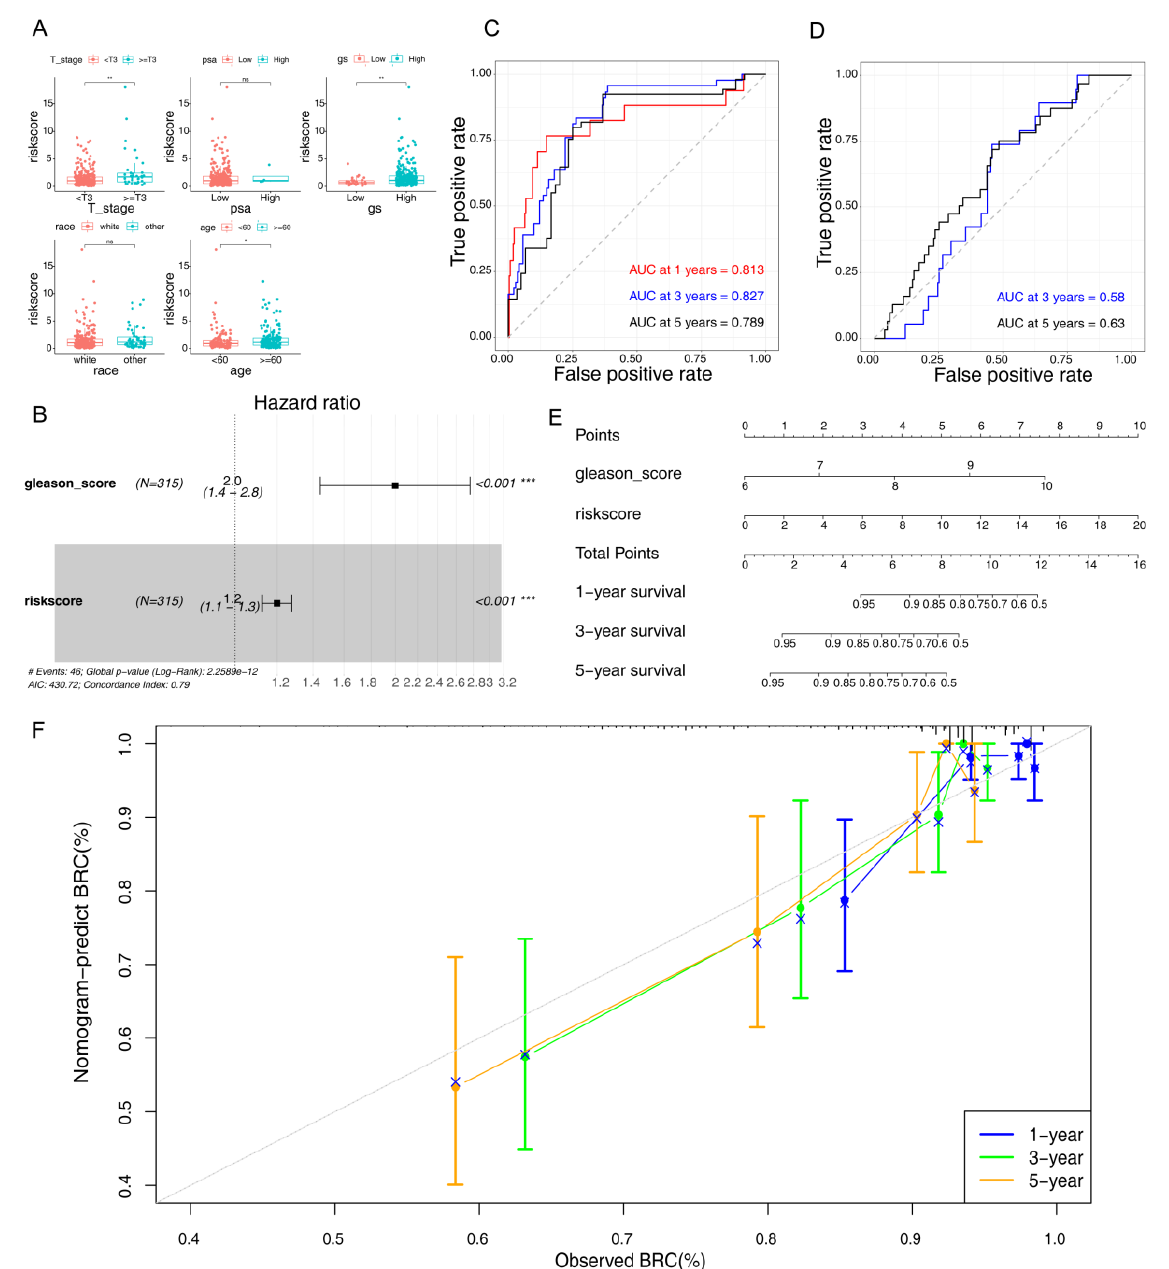
Figure 3. Correlation analysis between the risk model and clinicopathologic features. ( A ) Correlation between risk score and clinicopathologic features. The abscissa represents clinicopathologic features, and the ordinate represents the risk score. * p < 0.05; ** p < 0.01; ns, not significant. ( B ) Forest plots of univariate and multivariate Cox analyses. *** p < 0.001. ( C ) The ROC analysis of the independent prognostic model in the training set. ( D ) The ROC analysis of the independent prognostic model in the validation set. ( E ) A nomogram of the independent prognostic model. ( F ) Calibration curves of the nomogram.